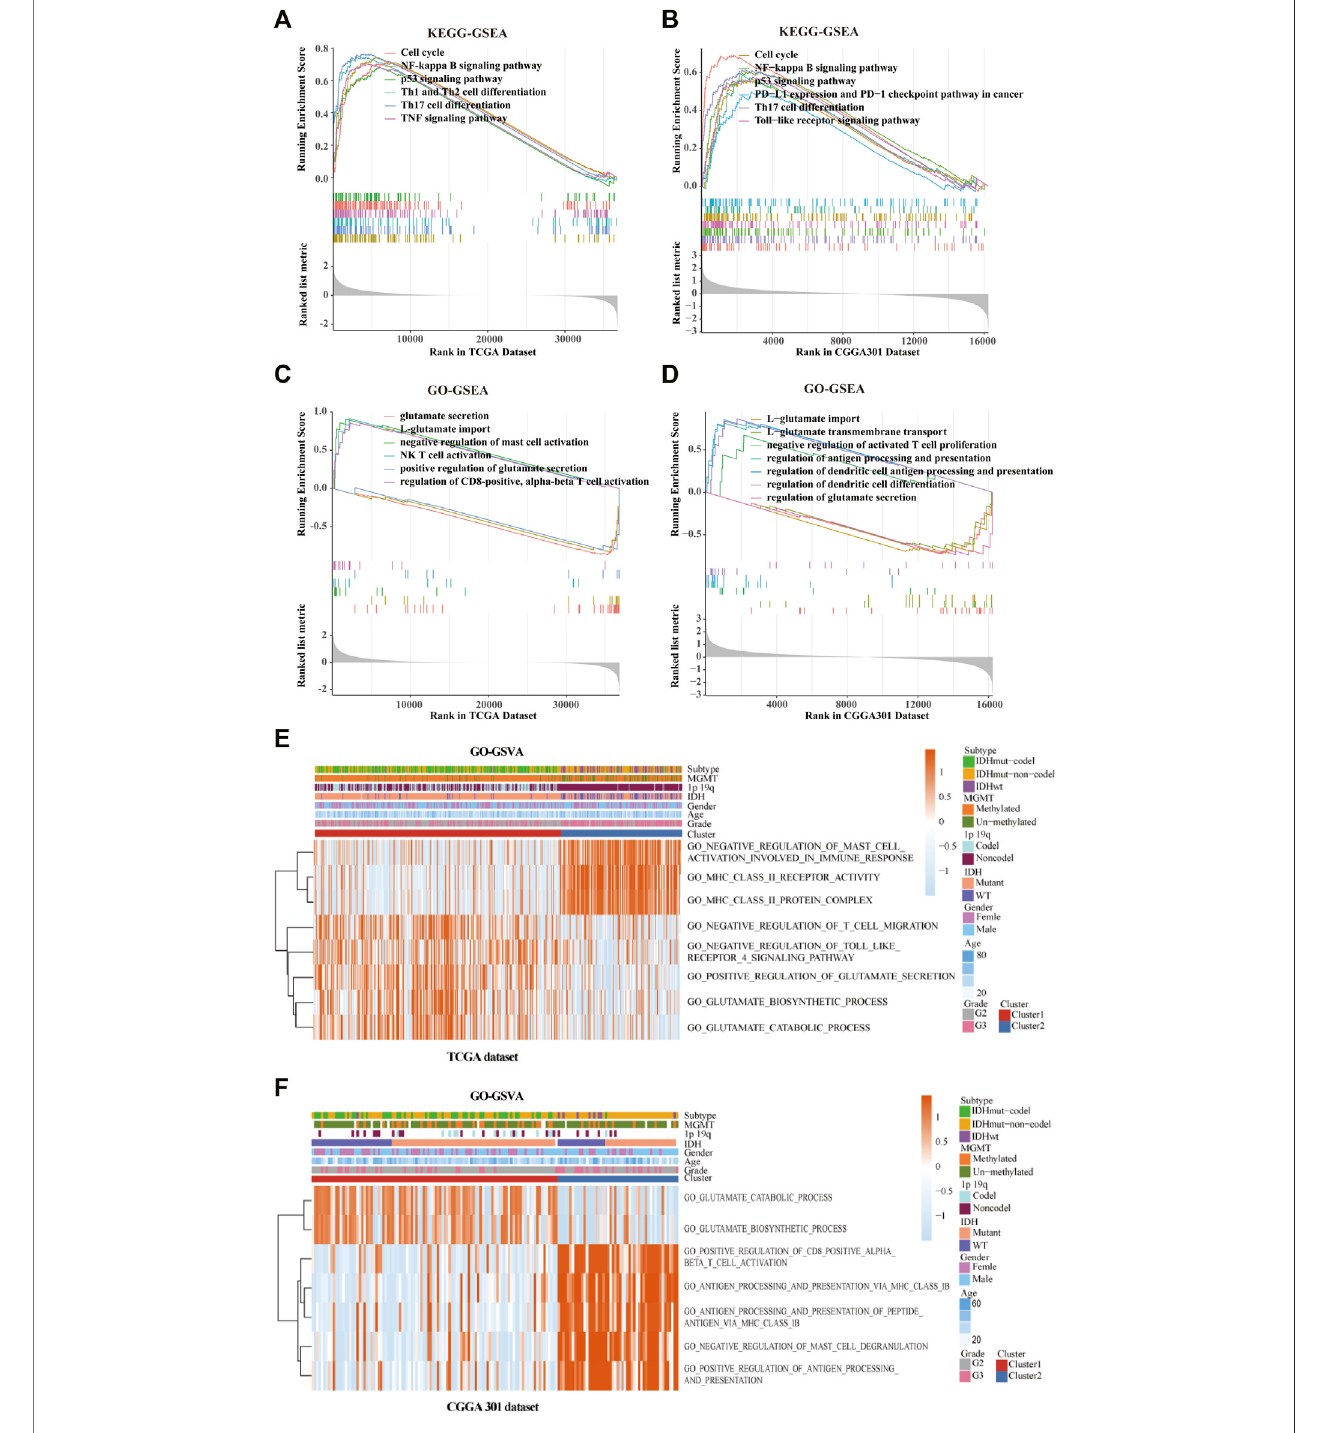
FIGURE 5| Gene ontology (GO) and Kyoto Encyclopedia of Genes and Genomes (KEGG) enrichmentanalysisof the cluster model based on gene set enrichment analysis (GSEA) and gene set variation analysis (GSVA). Enriched pathways between cluster 1 and cluster 2 based on KEGG-based GSEA analysis in TCGA (A) and CGGA301 (B) databases.Enriched pathways betweencluster1and cluster2based onGO-basedGSEAanalysisinTCGA (C) andCGGA301 (D) databases.Enriched pathways between cluster 1 and cluster 2 based on GO-based GSVA analysis in TCGA (E) and CGGA301 (F) databases.